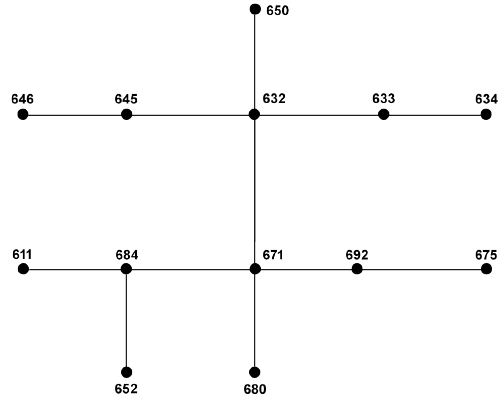
Figure 2. The modified IEEE 13-bus test